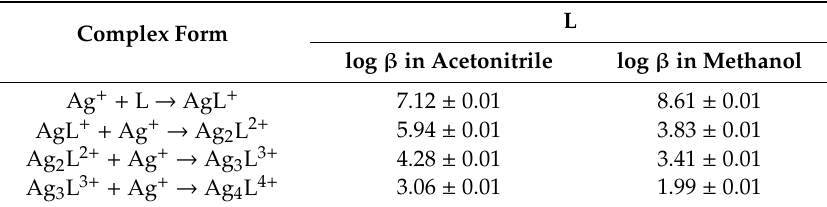
Table 1. The stability constants of the complexes of the investigated ligand with Ag + ions determined by potentiometric